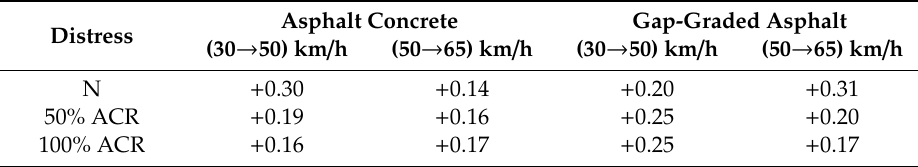
Table 7. Noise increments for AC and GGA by speed, in dBA / km / h. Asphalt Distress